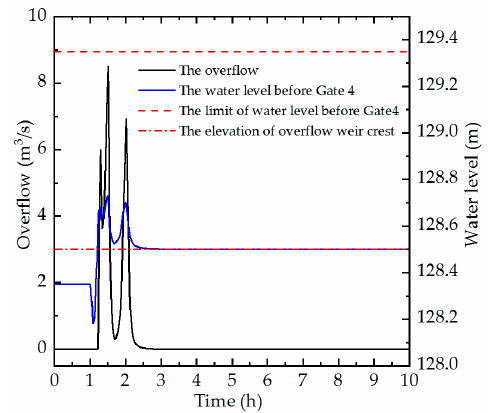
Figure 10. The overflow and water level in Pool 3.